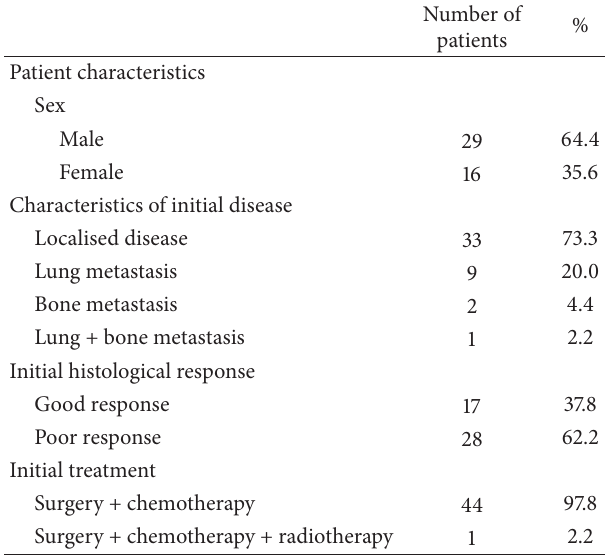
Table 2: Patient characteristics at the time of relapse or progression treated with high dose